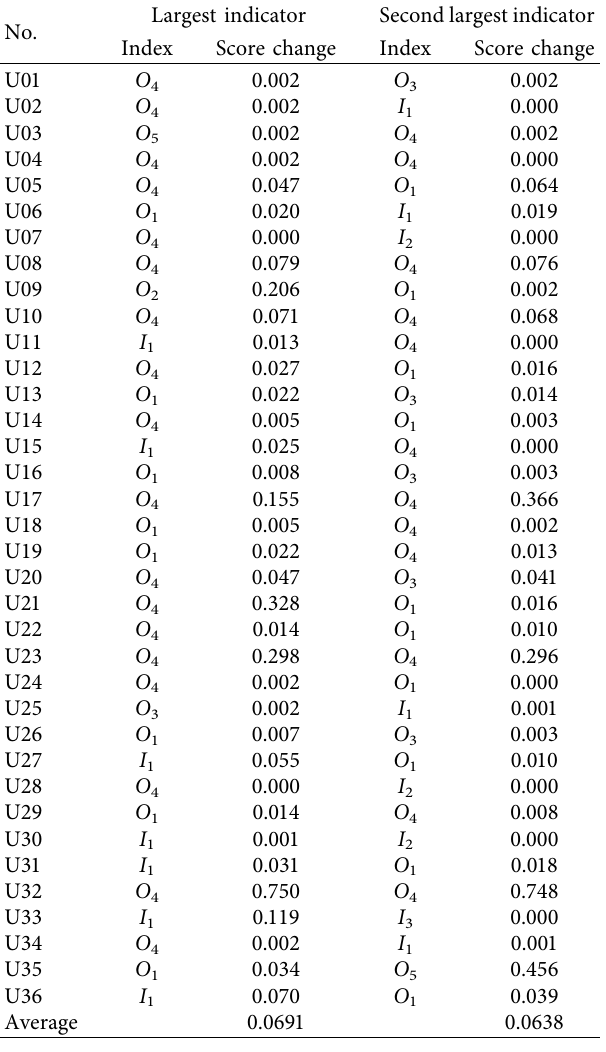
Table 7: Changes in teaching efficiencies of the 36 “Double First- Class” universities with changed index